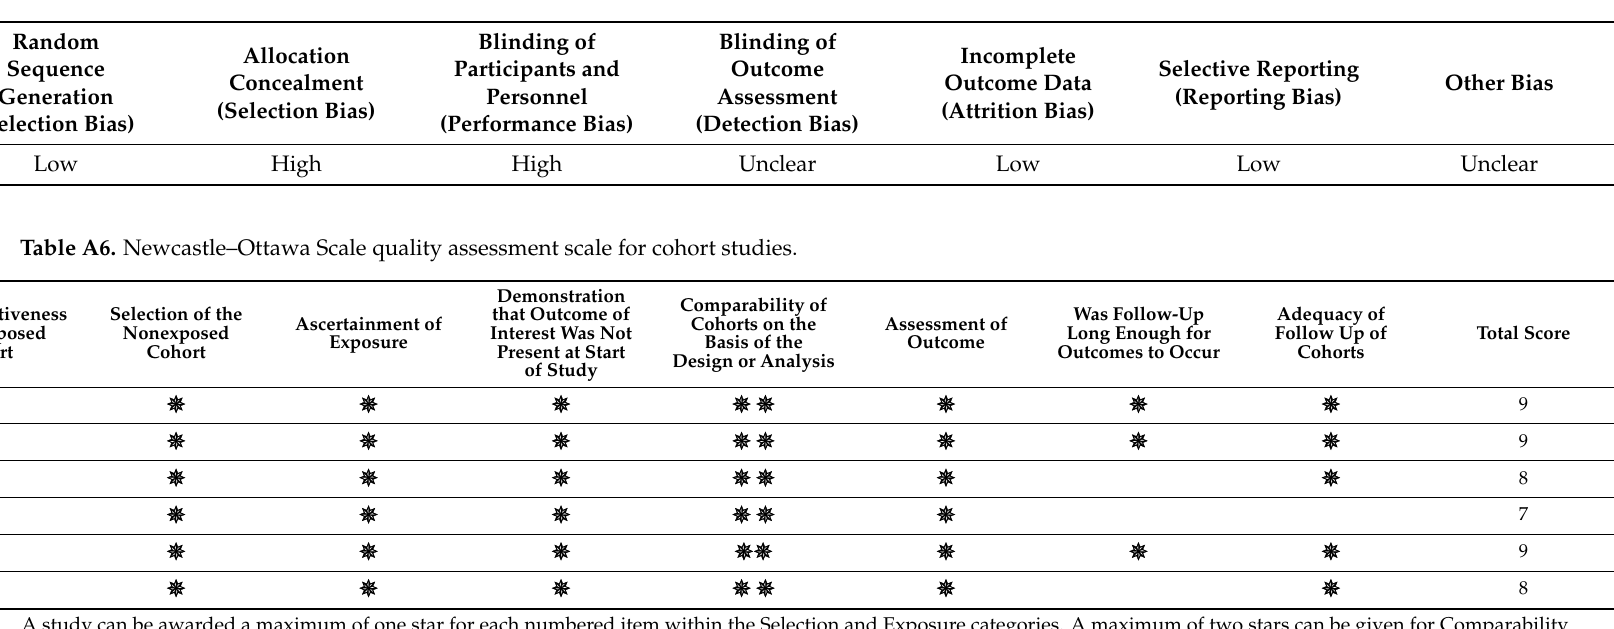
Table A7. GRADE Approach for Rating the Quality of Treatment Effect